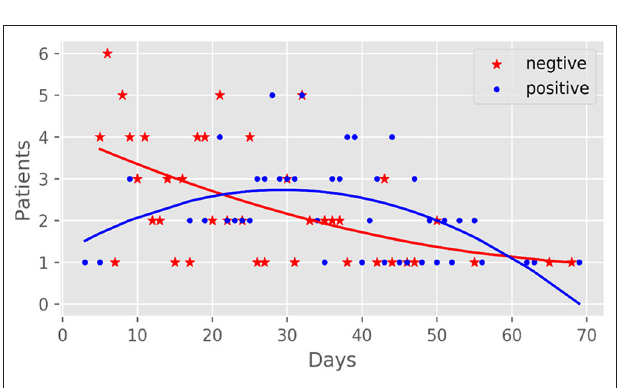
FIGURE 2 | The Time of nucleic acid turning negative in patients with COVID-19.